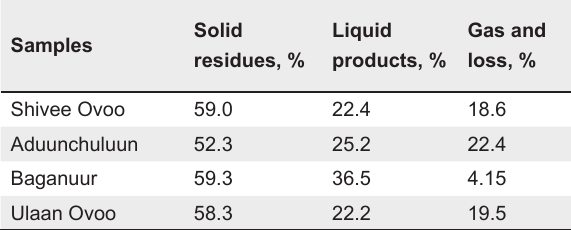
Table 2. The yields of pyrolysis products at 550- 650°C